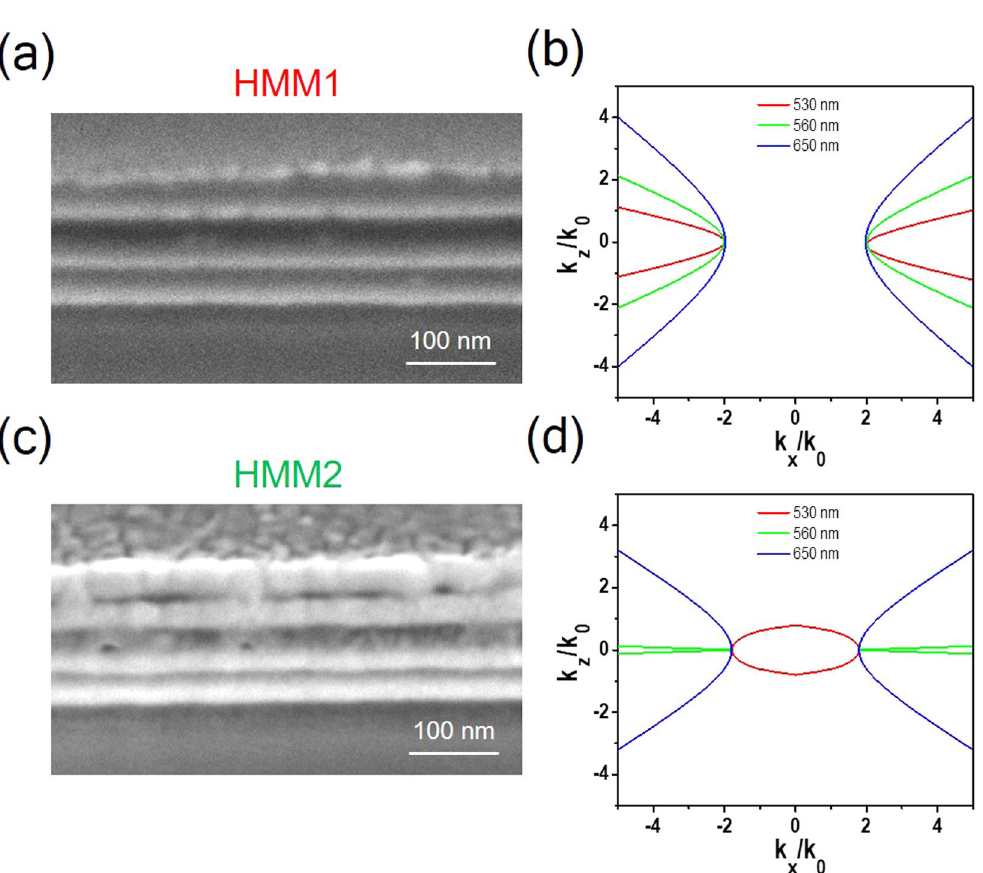
Figure 2. Properties of the transient HMMs. ( a ) is the cross-sectional field emission scanning electron microscopy (FE-SEM) image of the HMM1 with 4 pairs of gold (Au)/poly(vinyl alcohol) (PVA) with thicknesses of 25/42 nm. ( b ) is the iso-frequency curves performed at three wavelengths ( e.g ., 530, 560 and 650 nm) for the HMM1 sample. ( c ) and ( d ) are the FE-SEM image of the HMM2 sample with thicknesses of Au/PVA for 18/49 nm and its corresponding iso-frequency curves,